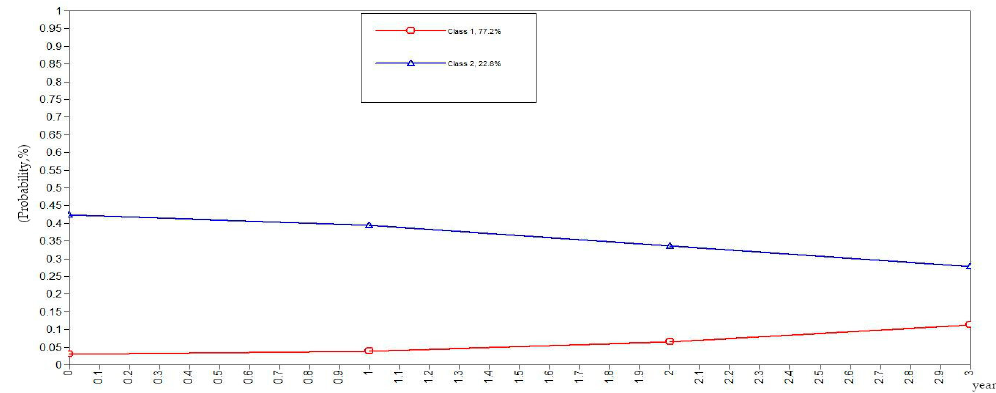
Figure 4. Evolution trends of the elderly with relatively positive health behaviors.